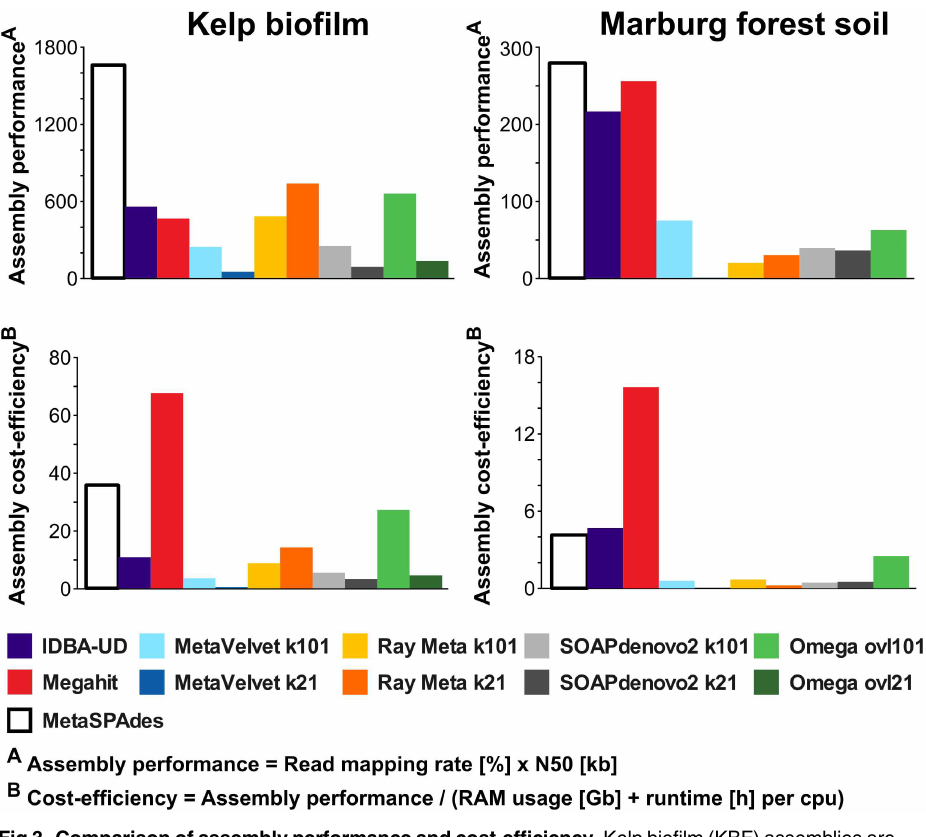
Fig 3. Comparison of assembly performance and cost-efficiency. Kelp biofilm (KBF) assemblies are shown on the left and Marburg forest soil (MFS) assemblieson the right. Assemblers utilizingsingle k-mer lengthswere tested with two different values for k , 21 and 101. Assembly performance was definedas the product of the respectiveread mappingrate (representing information content) and the respective N50.